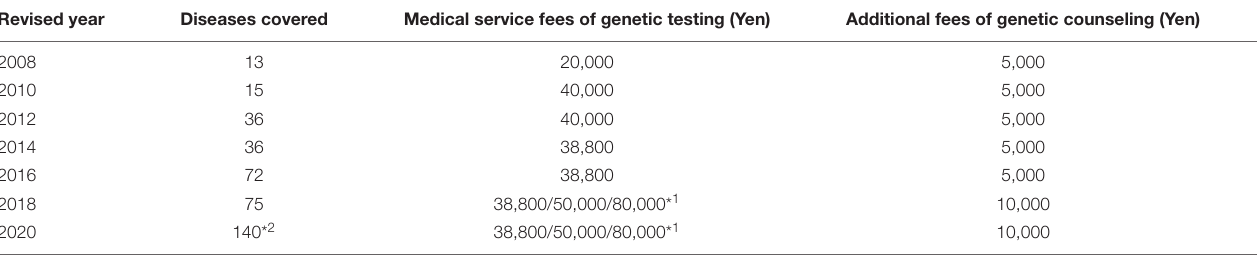
TABLE 1 | Reimbursement for genetic testing and genetic counseling in